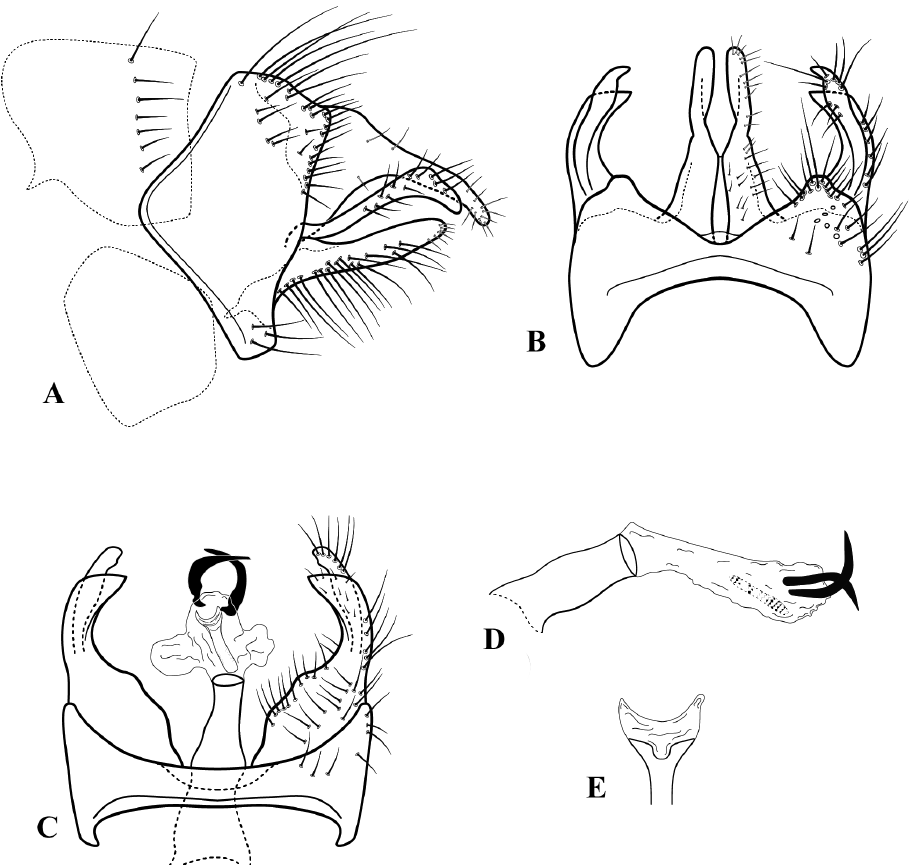
Figure 3. Silvatares holzenthali , new species, ♂ genitalia A lateral B dorsal C ventral D phallic apparatus, lateral E apex of phallic sclerite,